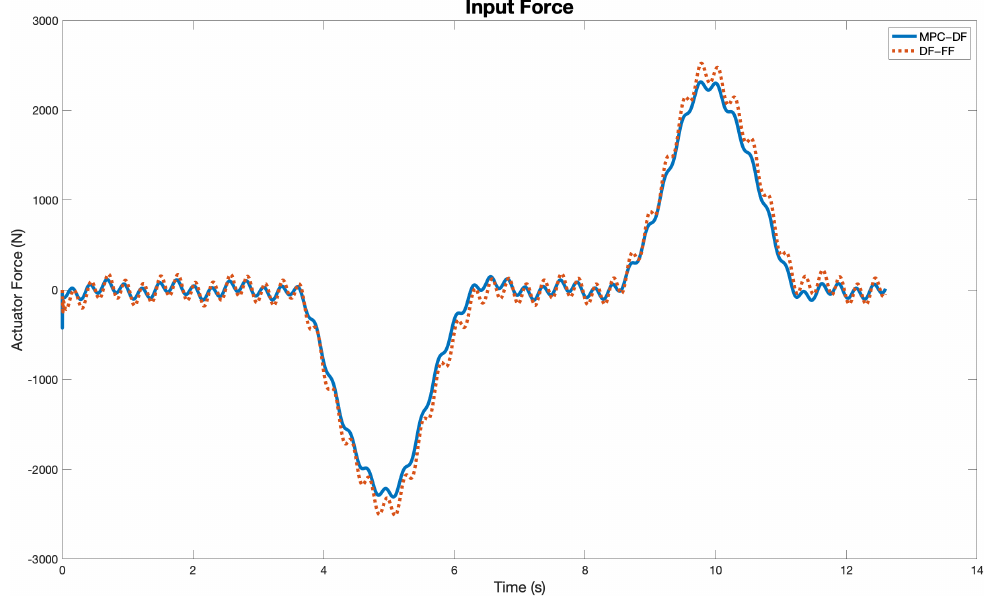
Figure 8. Input Force (Blue–MPC-DF, Red–DF-FF). Table 2. Peak Value Performances.